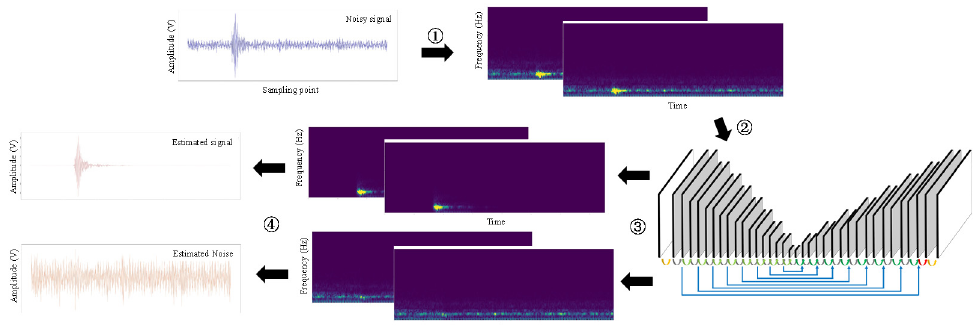
Figure 2. Flow diagram of the method. ① The noisy signal is transformed from the time domain into the time–frequency domain using Short Time Fourier Transform (STFT). ② The real and imaginary parts of time–frequency coefficients of noisy signals are input into the neural network. ③ Two masks from the network are applied to the real and imaginary parts of time–frequency coefficients of the input noisy signal to estimate the time–frequency coefficients of microseismic signal and noise, respectively. ④ The estimated signal and noise in the time domain are obtained via the inverse STFT.